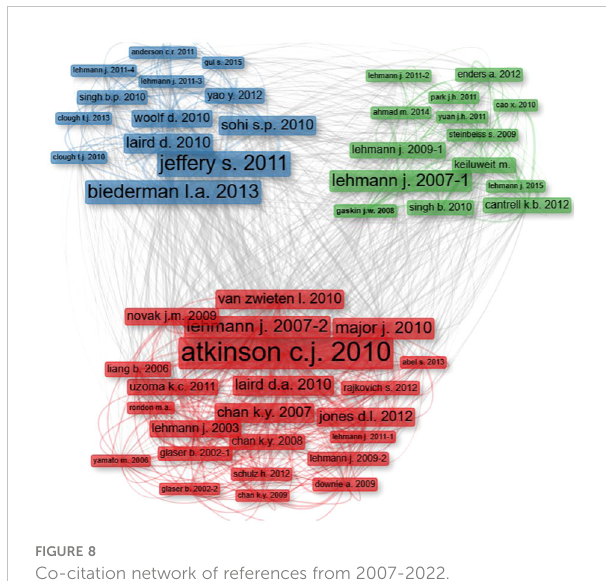
FIGURE 8 Co-citation network of references from 2007-2022.